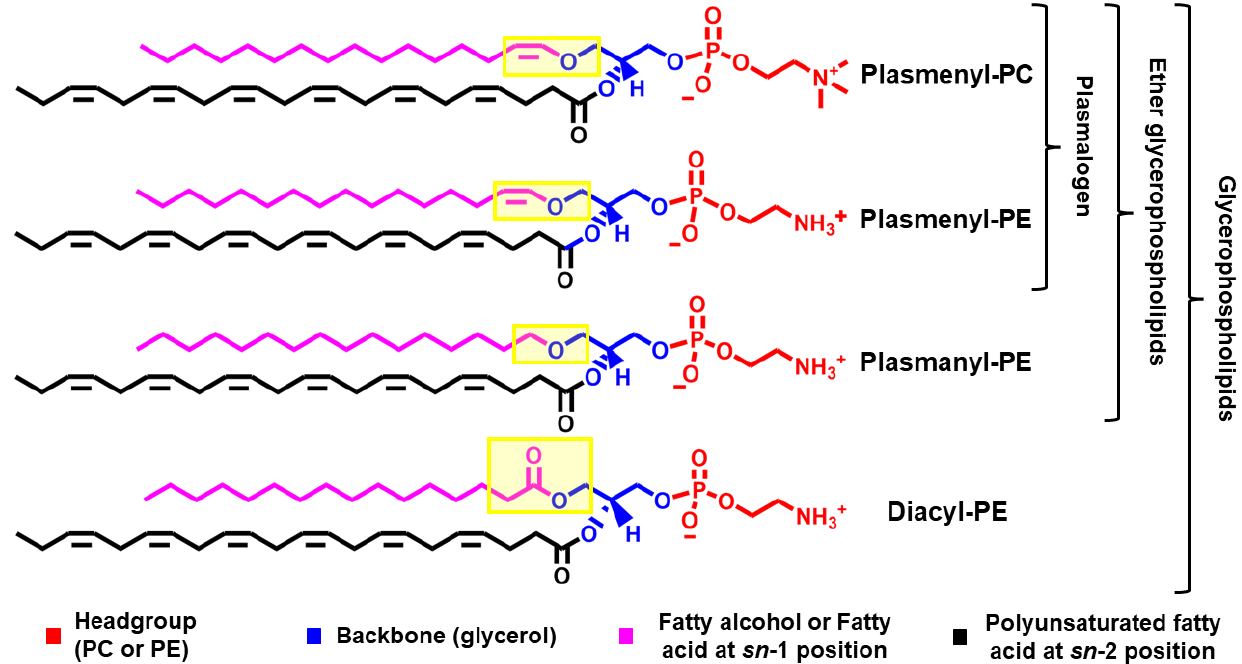
Figure 1. A comparison between the chemical structure of some glycerophospholipids. From top to bottom, the lipids are plasmenyl-PC (PC-Pls), plasmenyl-PE (PE-Pls), plasmanyl-PE, and diacyl-PE. The top two lipids differ in the nature of the headgroup (PC vs. PE). PC-Pls and PE-Pls are the major plasmalogen species in mammals. The bottom three lipids differ in the nature of the chemical bond linking the aliphatic chain (pink) to the sn -1 position of the glycerol (blue) moiety (highlighted in yellow), where PE-Pls has a vinyl-ether bond, plasmanyl-PE has an ether bond, and diacyl-PE has an ester bond.